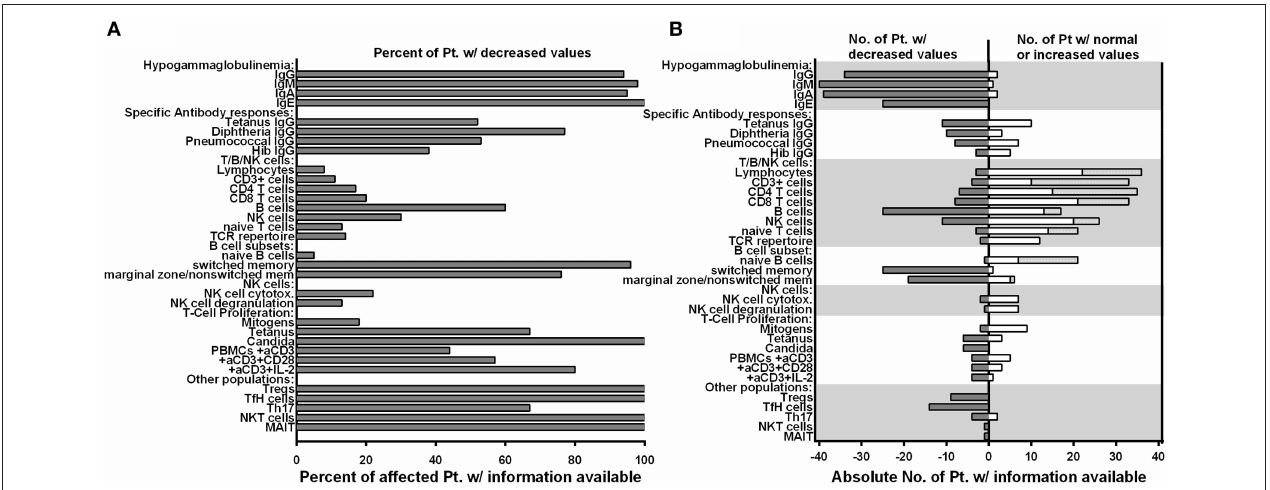
FIGURE 4 | Preserved T/NK cell numbers and function, but disturbed B cell differentiation, hypogammaglobulinemia and decreased lymphocyte subpopulations are consistent features of NF- κ B2 haploinsufficiency. (A) Fraction of affected patients relative to the whole cohort of patients of whom information was available regarding decreased values in the immunological phenotype depicted on the Y-axis. (B) Absolute numbers of patients with decreased values in different immunological assays are depicted on the left (solid gray bars), while the absolute number of patients with either normal or increased values are depicted to the right side (open white